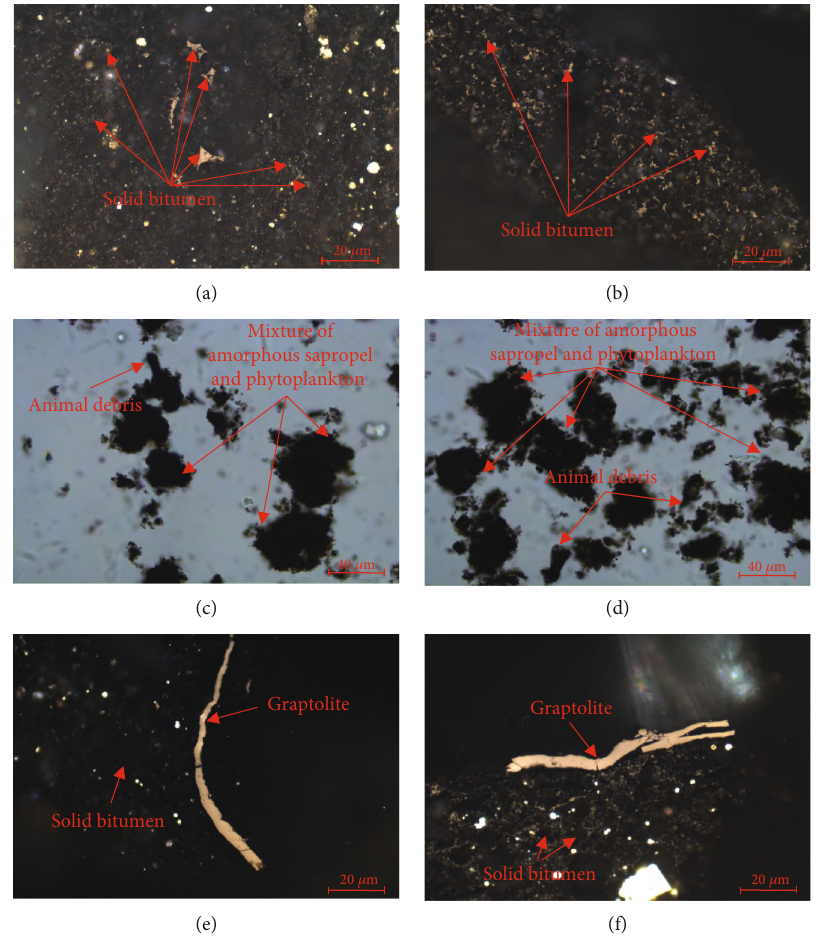
Figure 2: Organic matter macerals under microscope ((c, d) animal debris and mixture of amorphous sapropel and phytoplankton observed under re fl ected light; (a, b, e, f) graptolite and some solid bitumen observed under transmission